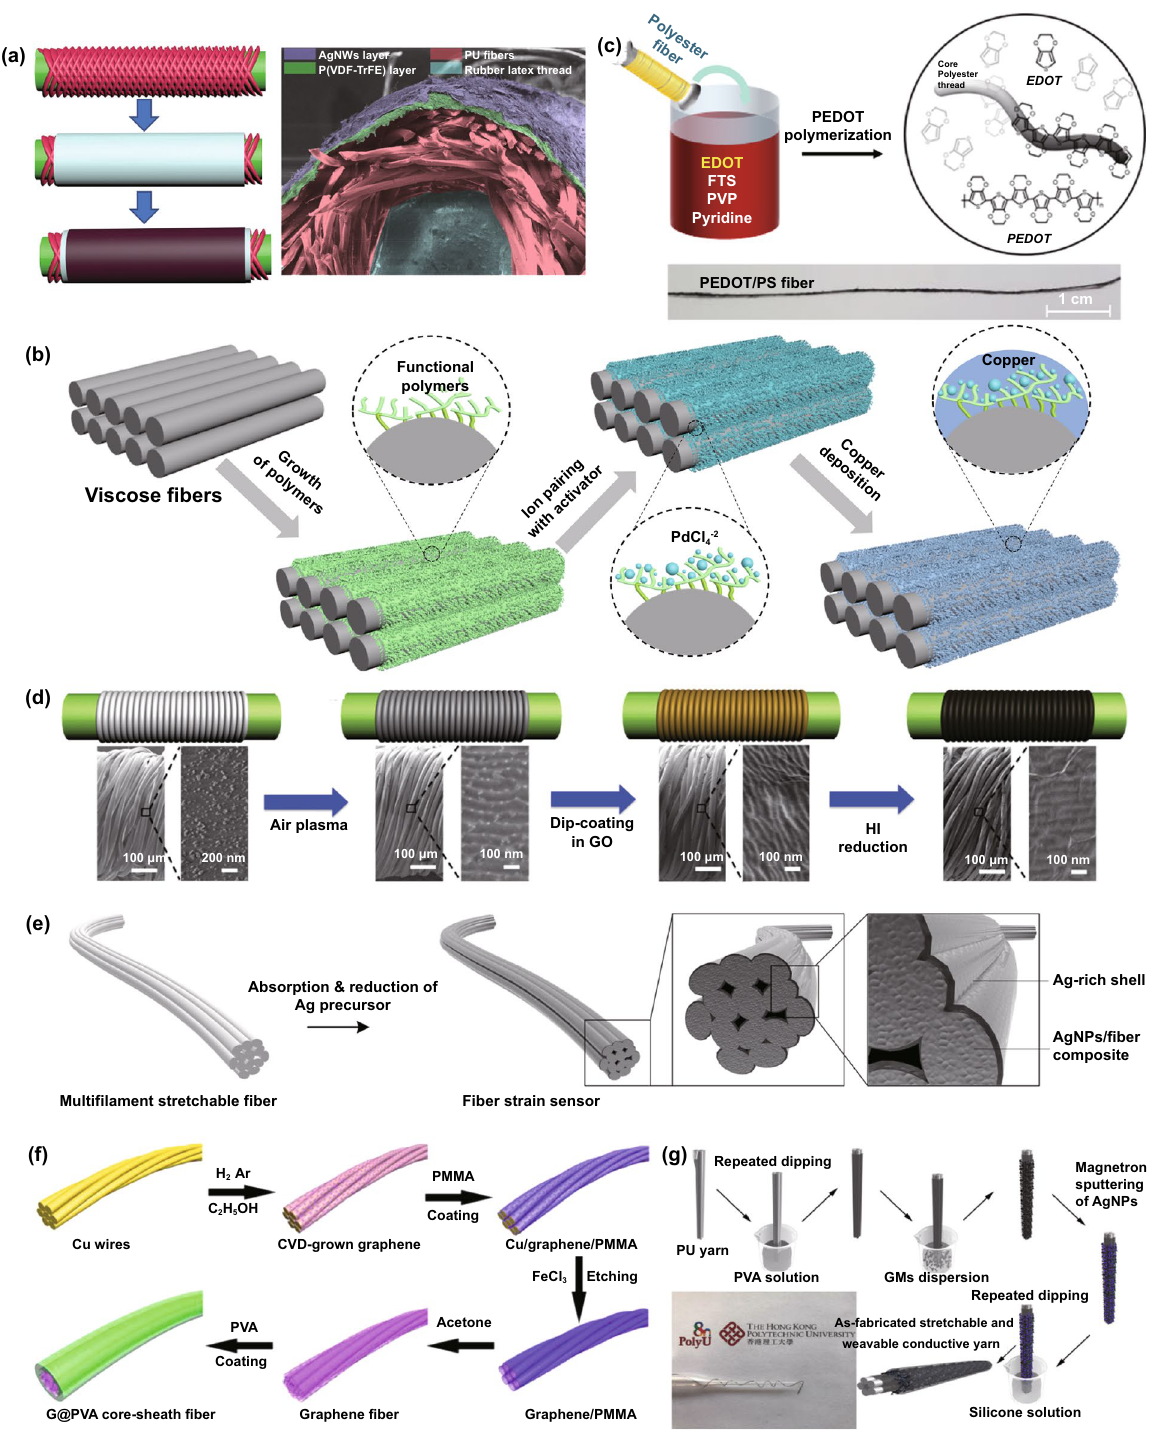
Fig. 2 a Illustration of P(VDF-TrFE)- and Ag NWs-coated elastic thread for linear strain sensors [113]. Copyright © 2016 Wiley–VCH. b Schematic diagram of depositing copper onto viscose fiber surface [6]. Copyright © 2021 Wiley–VCH. c In situ polymerization of polyester yarns by PEDOT [119]. Copyright © 2017 American Chemical Society. d Fabrication process of a spring-like strain sensor, with the structure of graphene-coated cover layer and PU core. e The illustration of Ag modified PU yarn for strain sensor with Ag-rich shell [123]. Copyright © 2018 American Chemical Society. f Fabrication of a strain sensor by modifying cop- per substrate with functional graphene and PVA [124]. Copyright © 2015 American Chemical Society. g A 1D coaxial-structured strain sensor consisted of PU core yarn, functional graphene and Ag NPs, and silicon encapsulated layer [125]. Copyright © 2018 Springer